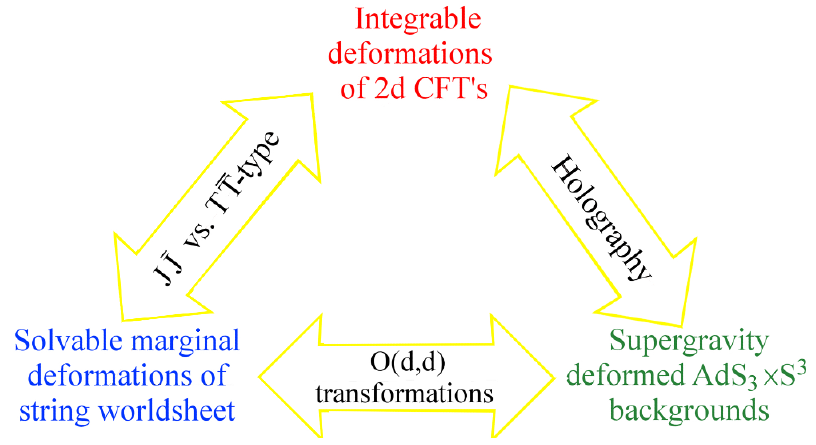
Figure 1 . Triangle of integrable deformations. The top corner denotes the integrable, irrelevant deformations of a 2d CFT, like single trace T (cid:22) T or J (cid:22) T deformations. The bottom left corner shows the general J (cid:22) J deformations, which are marginal deformations of the string worldsheet theory on AdS 3 (cid:2) S 3 background. These marginal deformations are dual to the irrelevant deformations of the 2d CFT. It has been shown in the literature that these deformations of WZW model are